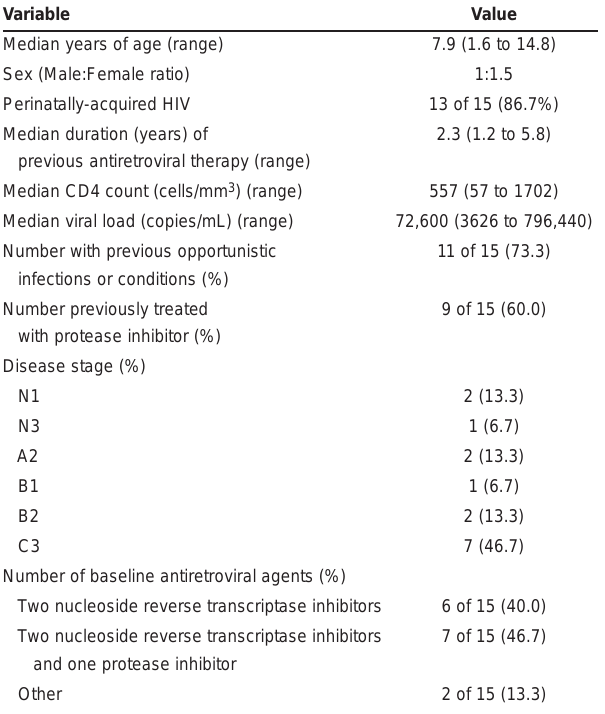
TABLE 2 CD4 count and viral load responses within 12 weeks